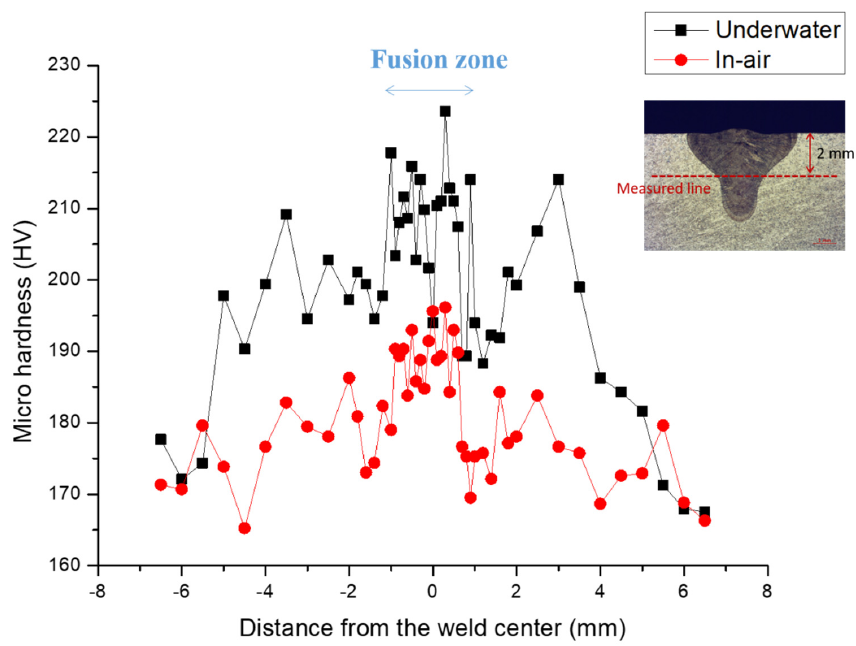
Figure 10. Vickers microhardness of specimens prepared by underwater laser welding and in − air laser welding.